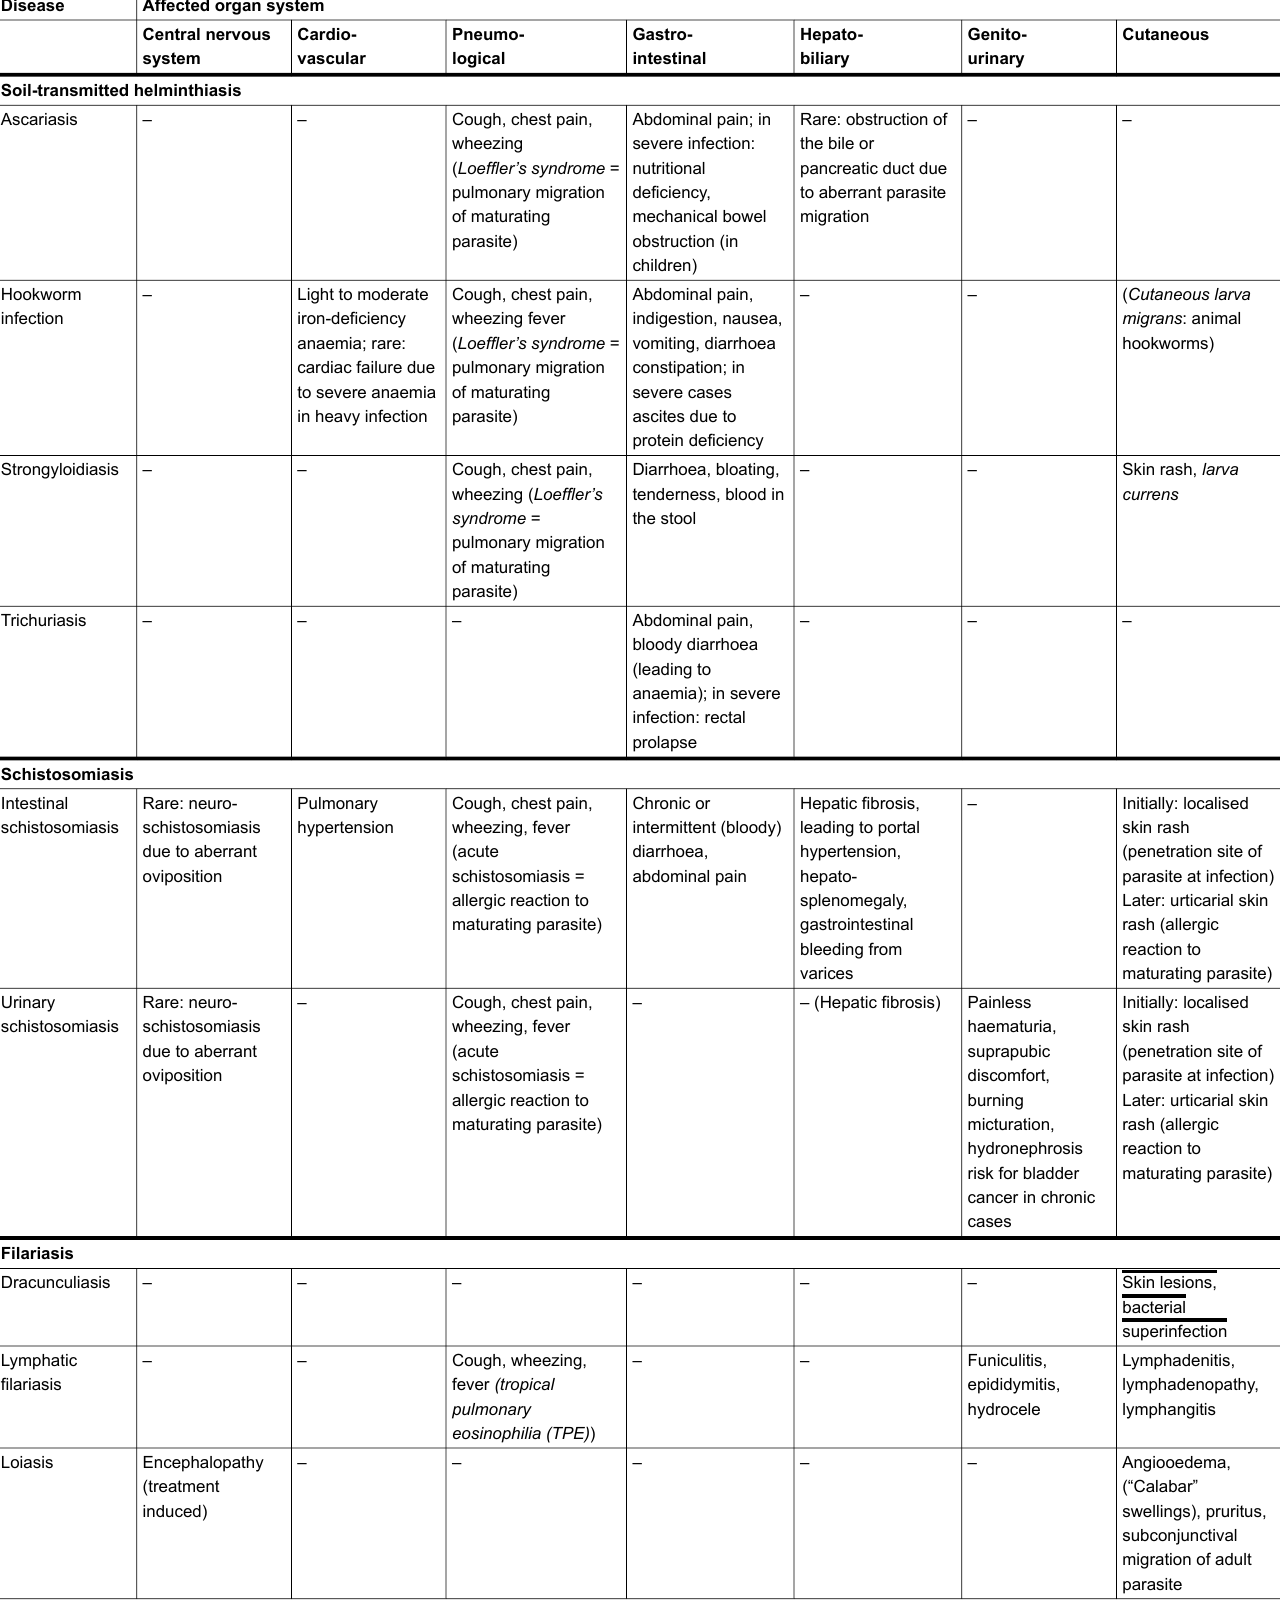
Table 4: Organ-specific clinical manifestations of selected neglected tropical diseases (helminth and protozoal infections).